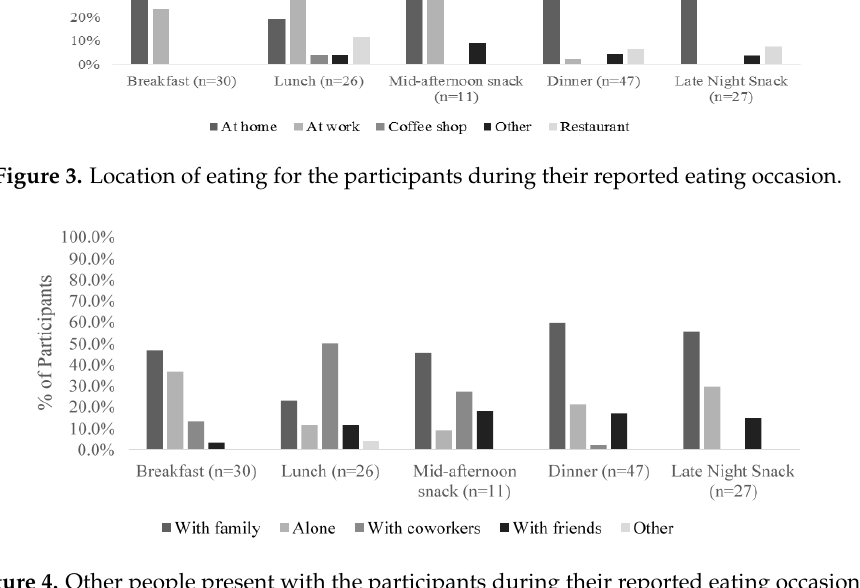
Figure 4. Other people present with the participants during their reported eating occasion.